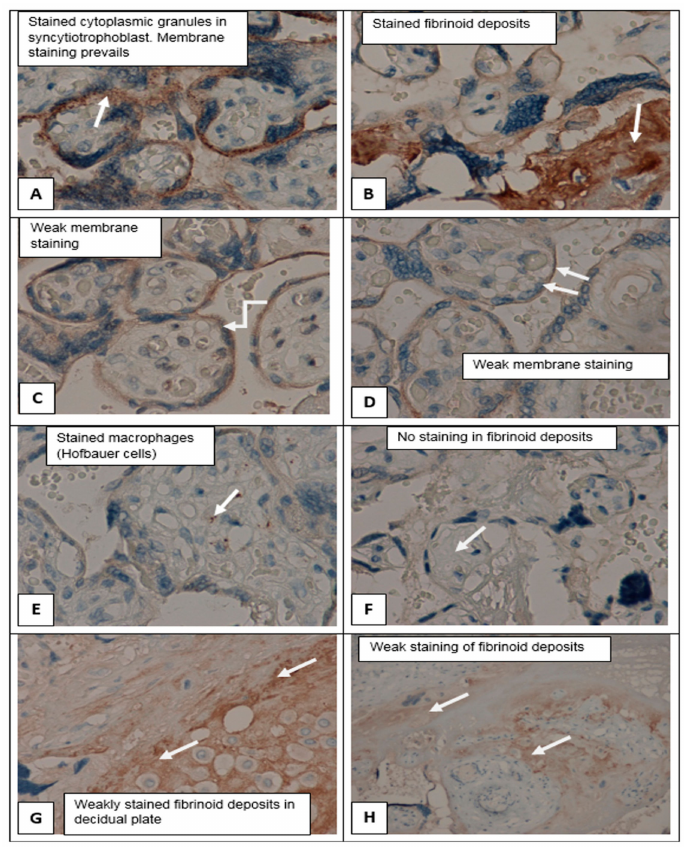
Figure 4. SERPINA1 expression in placenta samples in cases of chronic arterial hypertension and uncomplicated pregnancy. ( A , B ) Placenta villi in CAH group; membrane staining predominated. Fibrinoid deposits were stained. ( A , B ) × 400. ( C )–( H ) Placenta villi in uncomplicated full-term pregnancy. Weak staining of syncytiotrophoblast, predominantly membrane staining; fibrinoid deposits were not stained or weakly stained; ( C )–( F ) × 400; ( G ) × 200; ( H ) ×